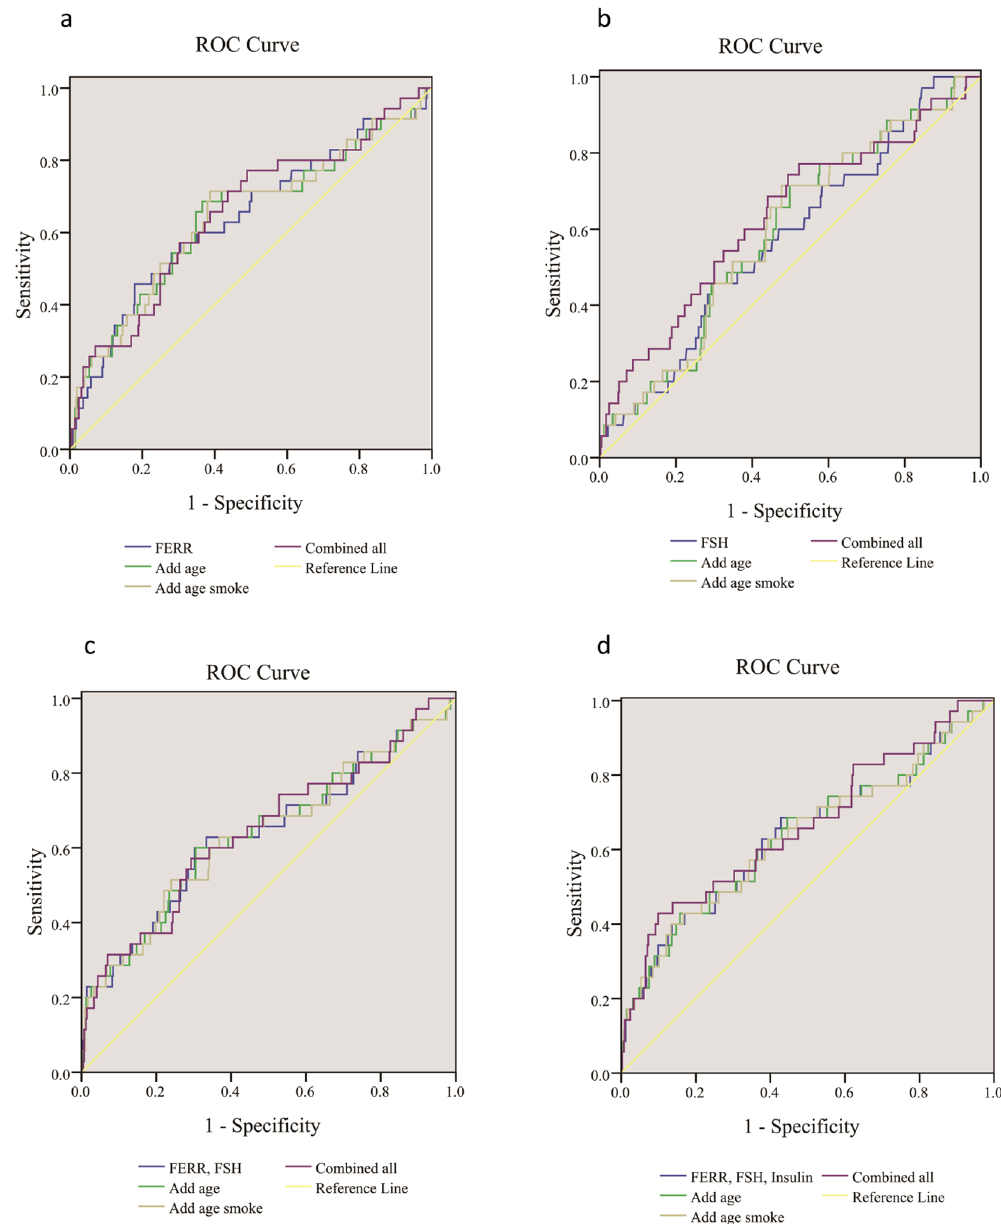
Figure 2. The ROC analysis with the significant biochemical markers for IIIa vs Normal group. * ( a ) FERR; ( b ) FSH; ( c ) FERR and FSH; ( d ) add biochemical markers discovered in multivariate logistic regression